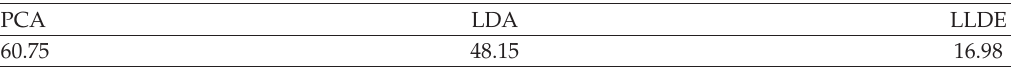
Table 1: The average error rates (cid:2) % (cid:3) of the PCA, LDA, and LLDE, across ten tests and four